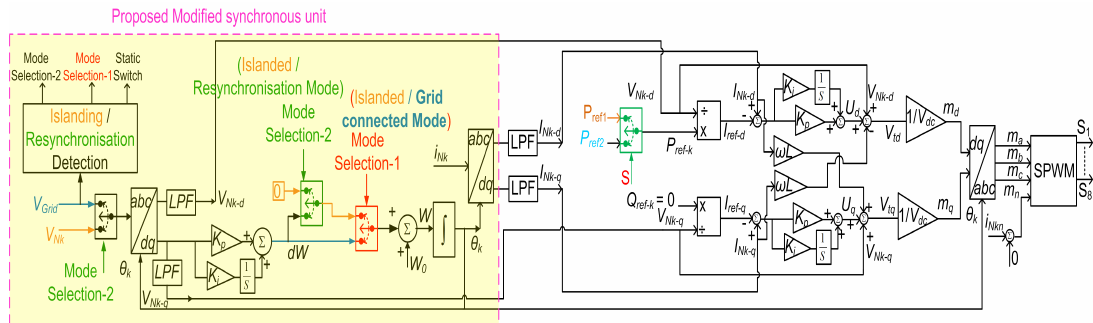
Figure 5. Proposed Power Control Scheme for DG during grid connected operating